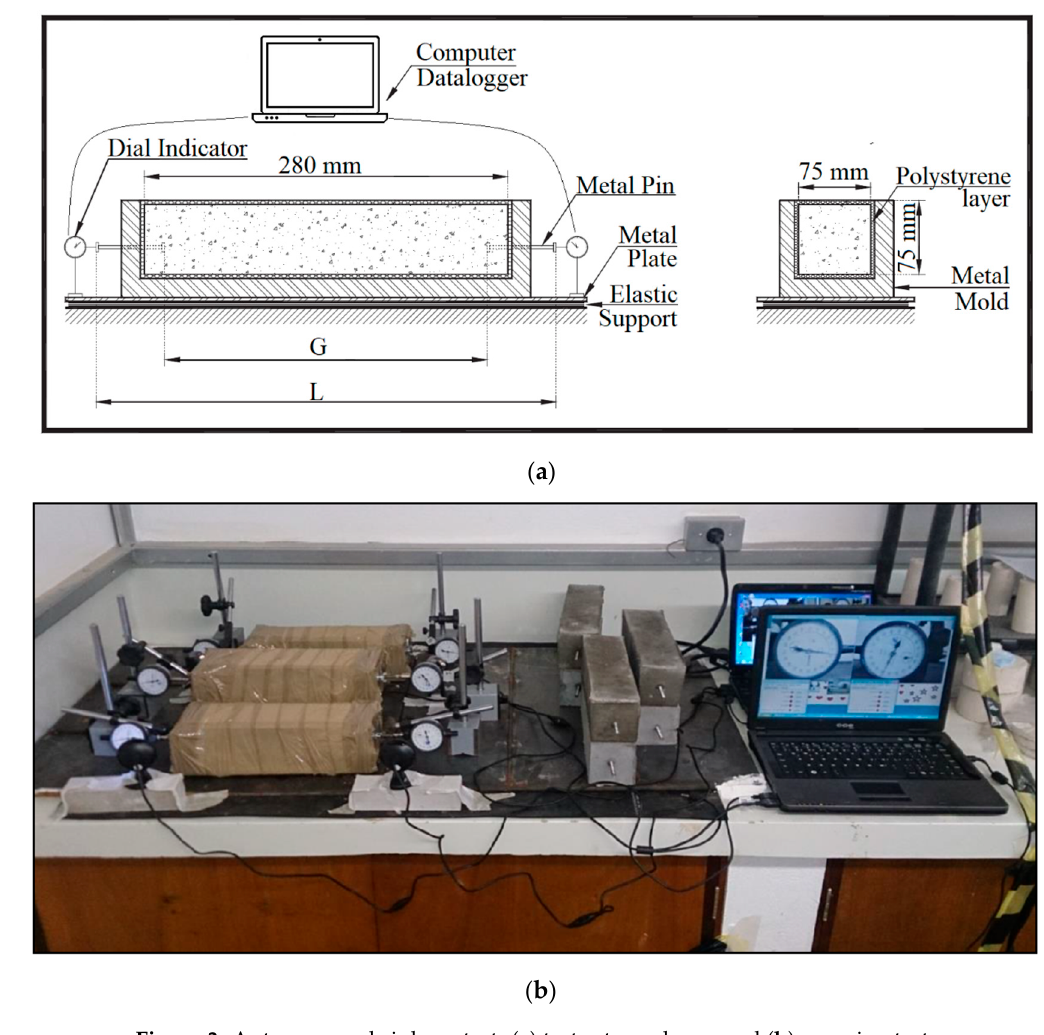
Figure 3. Autogenous shrinkage test: ( a ) test setup scheme and ( b ) on going test.